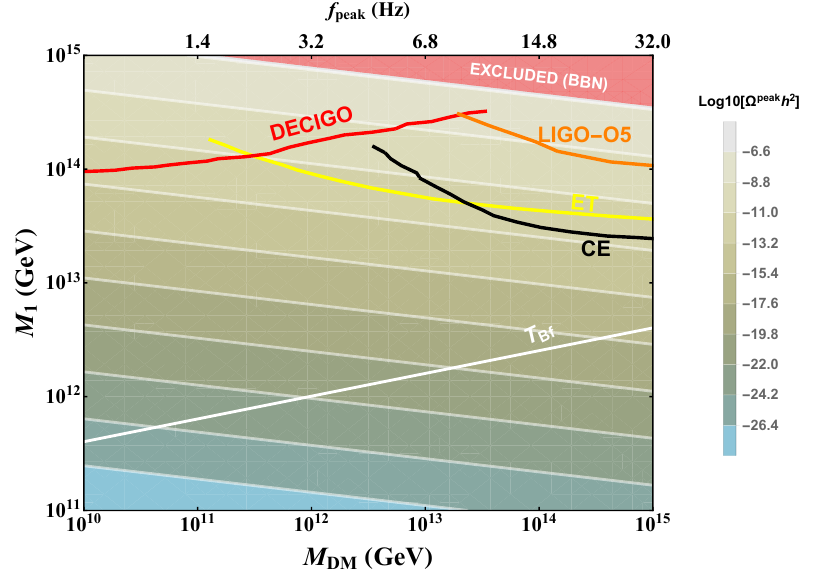
Figure 3 . Contours of Ω peak on the M 1 − M DM plane. The red-shaded region is excluded because GW otherwise the induced GWs would saturate the BBN bound on the effective number of neutrino species. The sensitivity limits of various experiments are shown with the coloured lines. The white line represents the PBH formation temperature, T Bf ∼ f ( M BH ) , expressed as a function of DM mass (cf. eq.